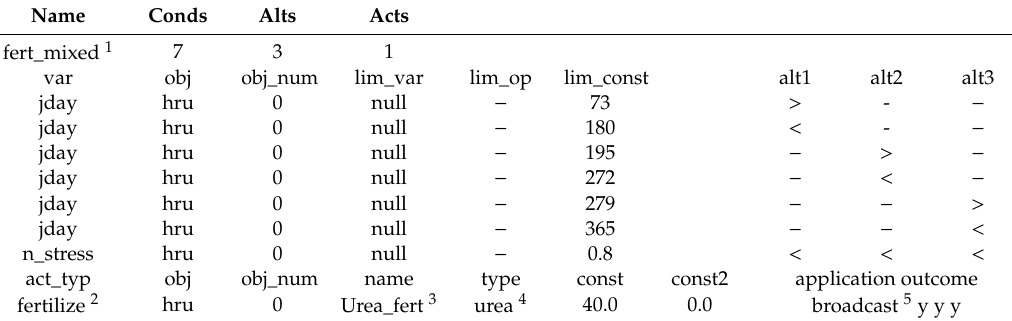
1 name assigned to the decision table, for the other variable meanings, refer to Table 5 above. Table 7. Decision table for fertilization application in SWAT + for both